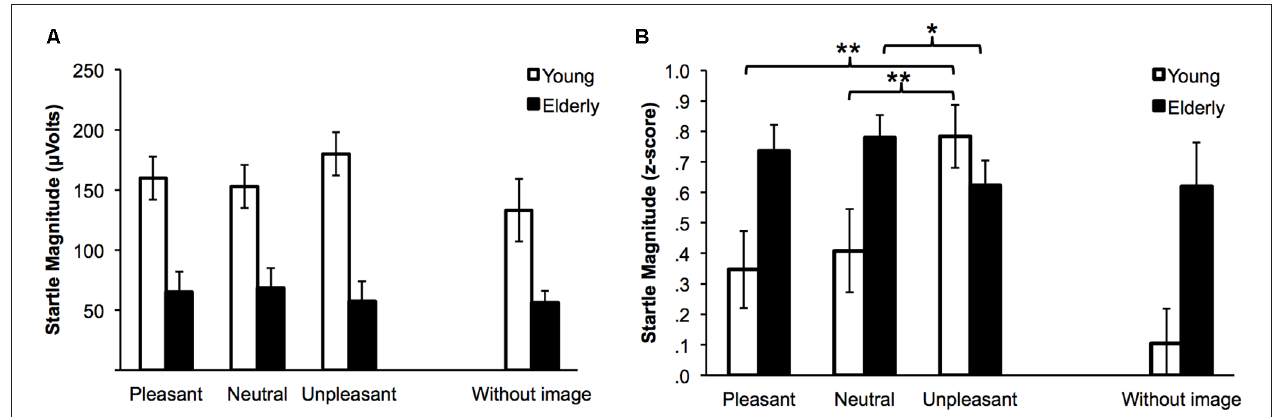
FIGURE 2 | Mean raw magnitude (A) and normalized data (B) of startle blink responses while viewing pleasant, neutral and unpleasant images for Young adults and Elderly. The without-image condition is shown for comparison. Error bars are standard errors. ∗ p < 0.05; ∗∗ p < 0.01.